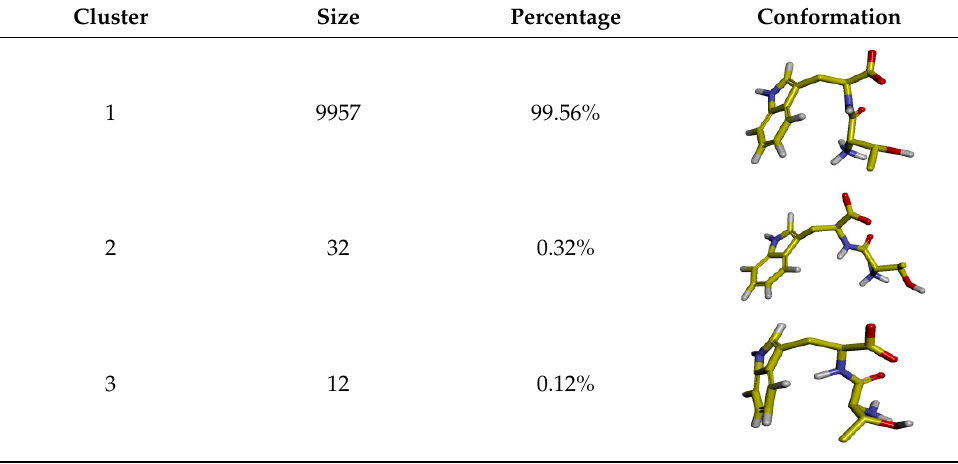
Table 2. The cluster size and the representative conformations of WA collected in the first six clus ‐